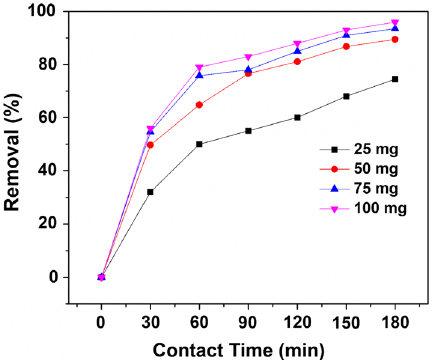
Fig. 10 Freundlich adsorption curve of Cr(VI) adsorption on CTAB–